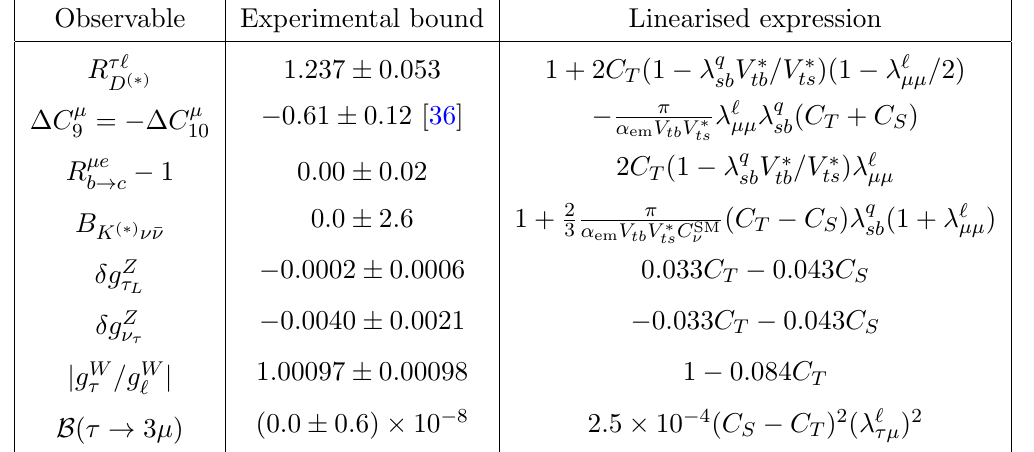
Table 1 . Observables entering in the (cid:12)t, together with the associated experimental bounds (as- suming the uncertainties follow the Gaussian distribution) and their linearised expressions in terms of the EFT parameters. The full expressions used in the (cid:12)t can be found in appendix